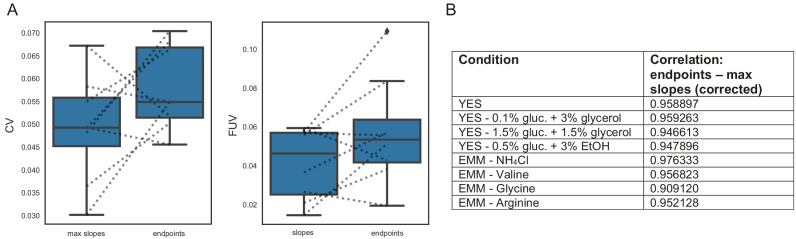
57 wild strains analysis summary.(A) Distribution of CVs and FUVs (based on 96 replicates of the control strain 972 evenly dispersed through the plate, normalised for spatial effects with grid correction) across 8 conditions. Using maximum slopes instead of endpoints usually results in lower noise levels. (B) Table listing the correlation between corrected maximum slopes and corrected enpoints.